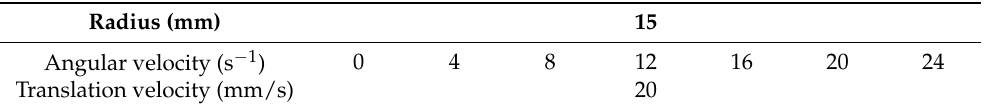
Figure 10. Variation curve of powder layer density under different angular velocities of powder recoaters. Table 5. Motion parameters and structural parameters with different angular velocities during the movement of the powder recoater.